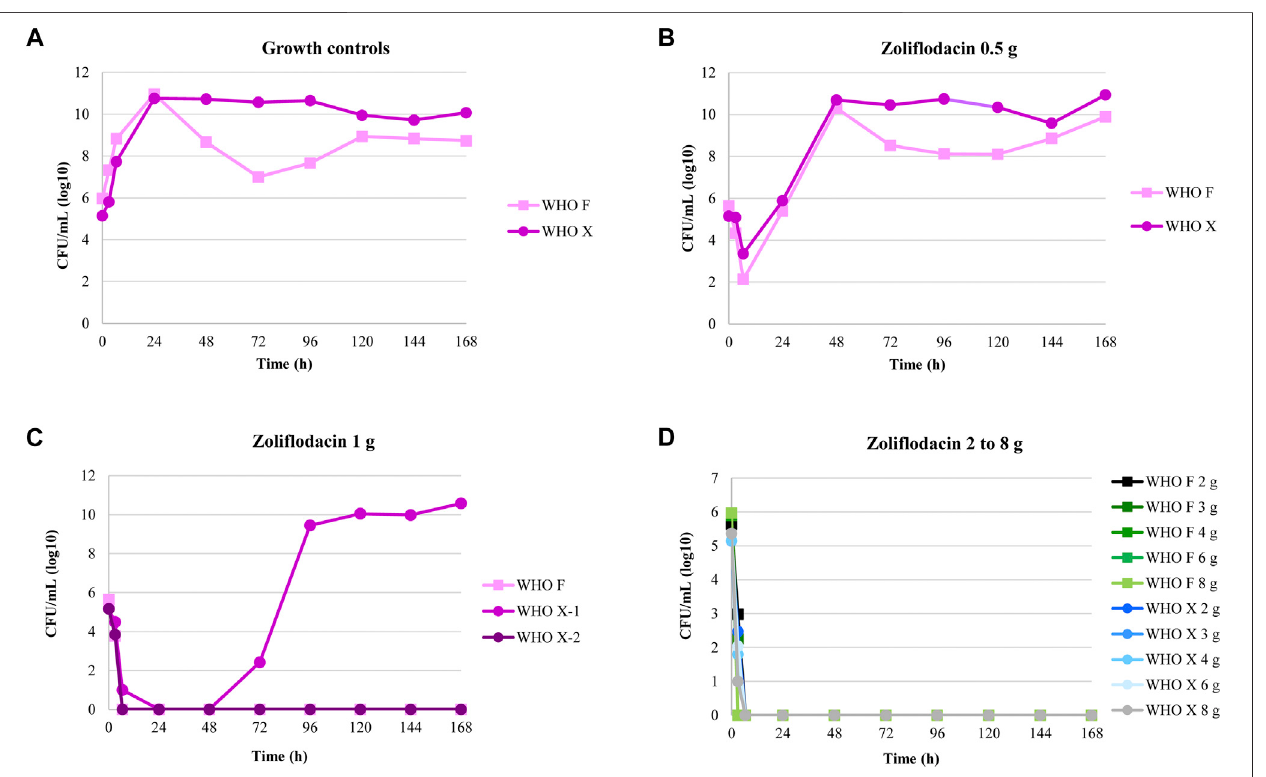
FIGURE 1 | Growth curves of the total population of two Neisseria gonorrhoeae strains (WHO F and WHO X) in the dose-range hollow fi ber infection model (HFIM) experiments ( n (cid:1) 2) simulating zoli fl odacin single oral dose of 0.5, 1, 2, 3, 4, 6, and 8 g and followed for seven days. Notable, WHO X regrow after treatment with zoli fl odacin 1 g in one of the two